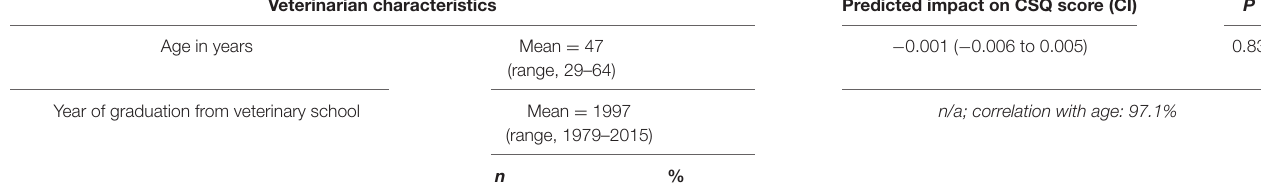
TABLE 1 | Description of participating veterinarians ( n = 60) and predicted impact on Client Satisfaction Questionnaire (CSQ) score in univariable linear regression. Veterinarian